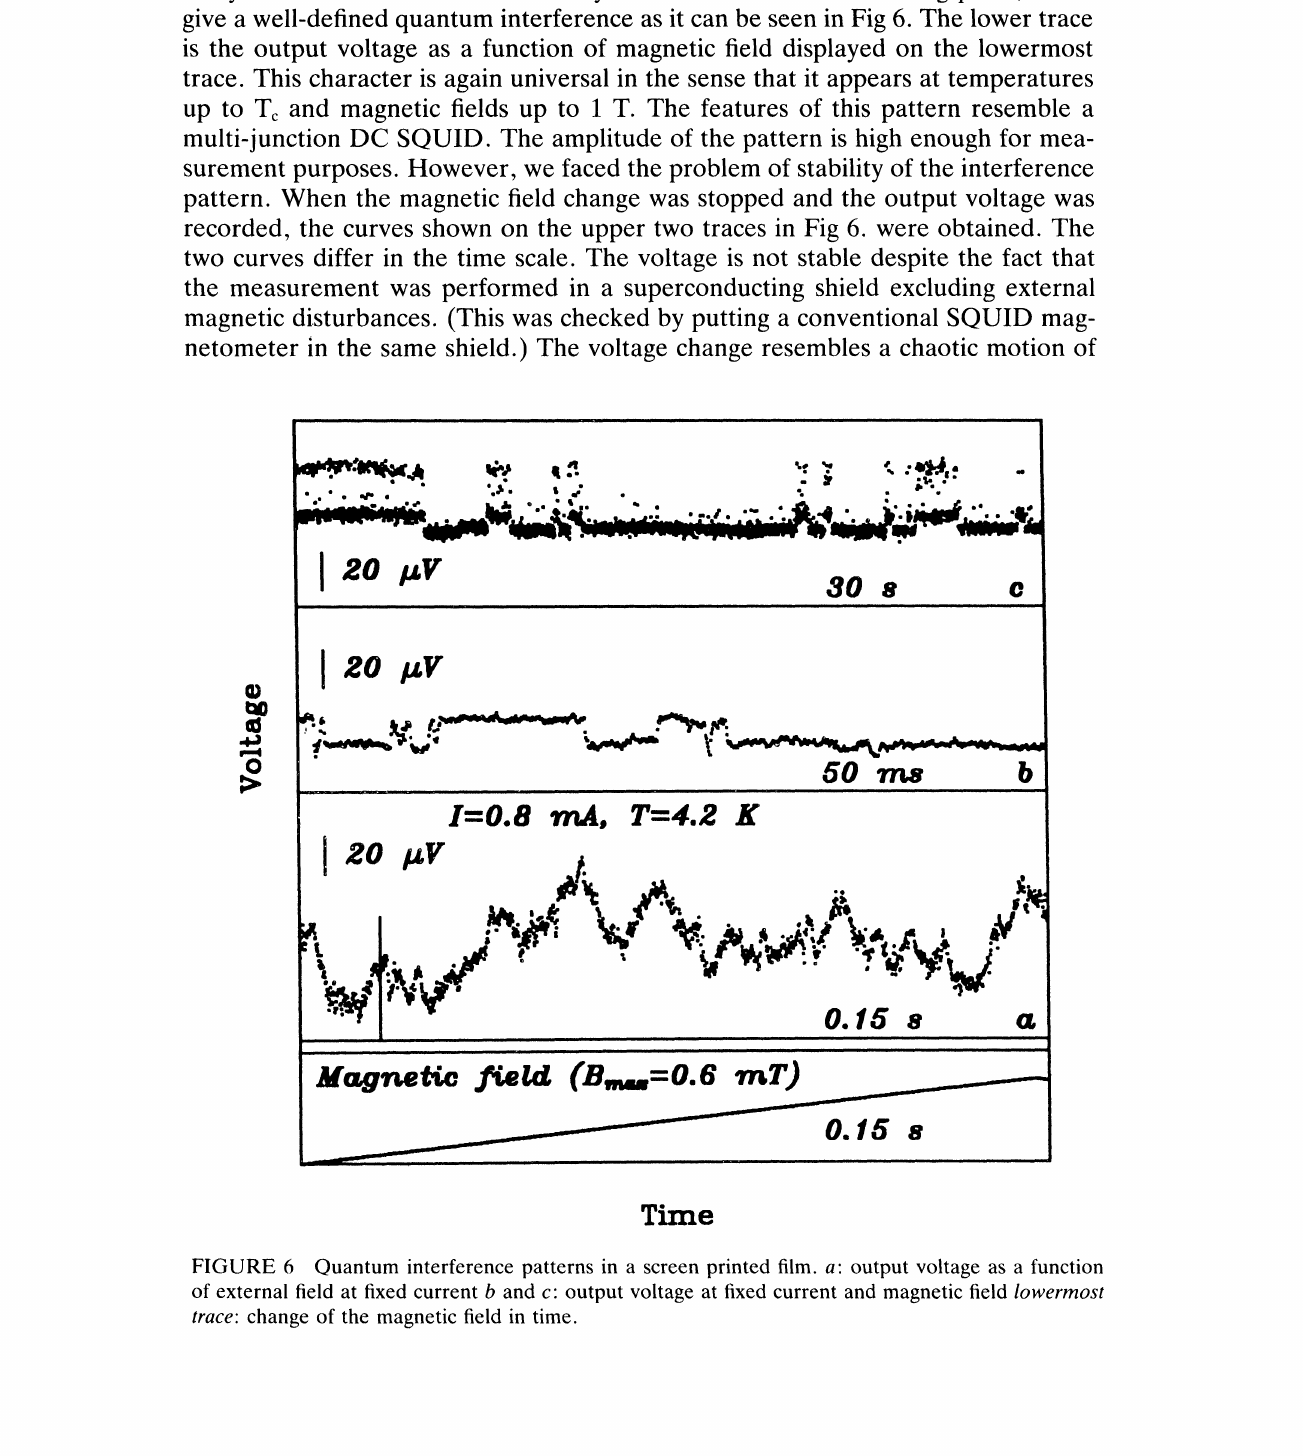
FIGURE 6 Quantum interference patterns in a screen printed film. a’ output voltage as a function of external field at fixed current b and c: output voltage at fixed current and magnetic field lowermost trace: change of the magnetic field in